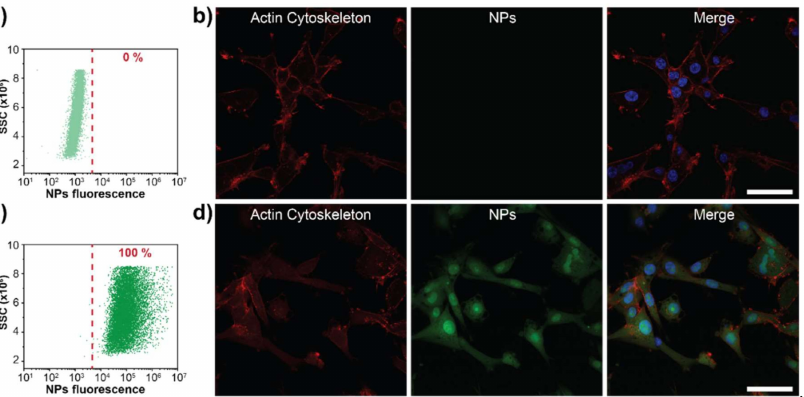
Figure 6. PEG-PDHA NPs uptake by U87MG cells. ( a ) Flow cytometry and ( b ) confocal images of intact U87MG cells. ( c ) Flow cytometry and ( d ) confocal images of U878MG cells co-cultured for 1 h with PEG-PDHA NPs. TRITC-conjugated phalloidin was used to stain for actin cytoskeleton (red), Eosin isothiocyanate was used to label PEG-PDHA NPs (green) and 4 (cid:48) ,6-diamidino-2-phenylindole (DAPI) was used to stain the nuclei (blue). Scale bar = 50 µ